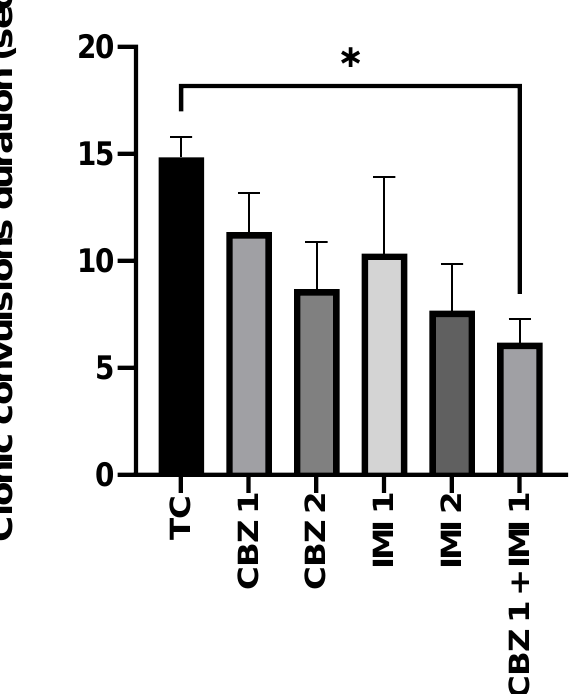
Figure 2. The effect of CBZ (20 and 50 mg/kg), IMI (10 and 20 mg/kg) and CBZ (20 mg/kg) + IMI (10 mg/kg) on the duration of clonic convulsions. Statistical significance between means from toxic control and other groups was correlated by applying one-way ANOVA followed by post hoc Dunnet’s test. p < 0.05 * was considered significant. CBZ, IMI, and TC indicate carbamazepine, imipramine, and toxic control, respectively.